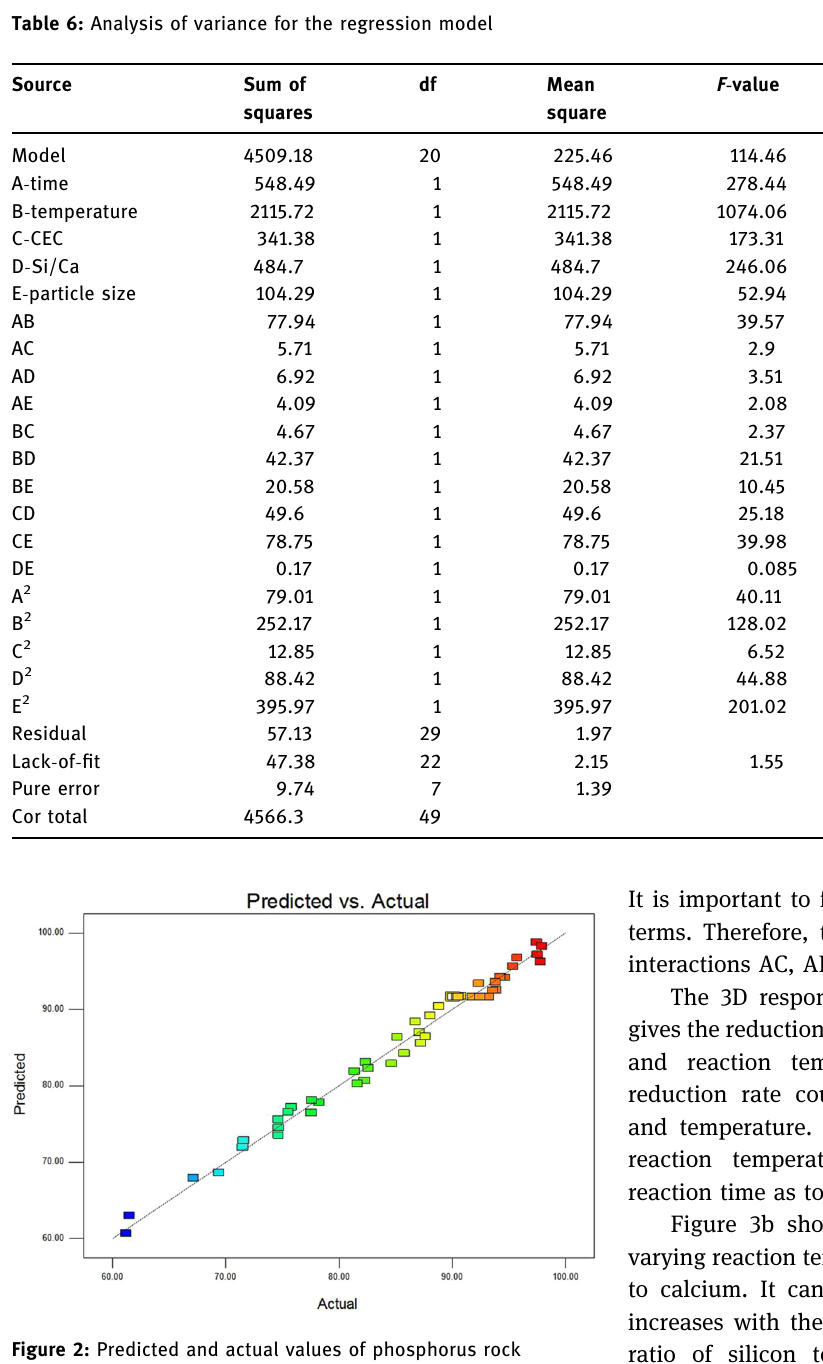
Figure 2: Predicted and actual values of phosphorus rock reduction